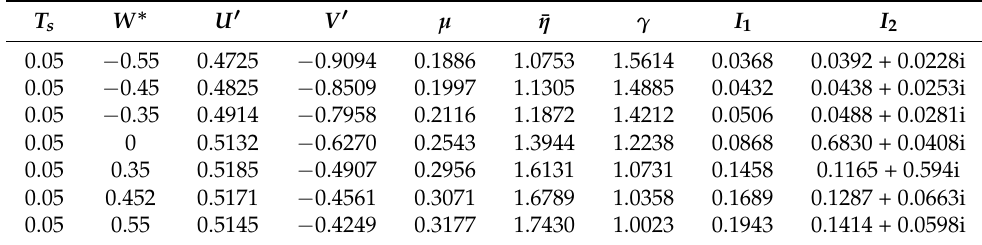
Table 3. Values of stability parameter corresponding to several suction and injection